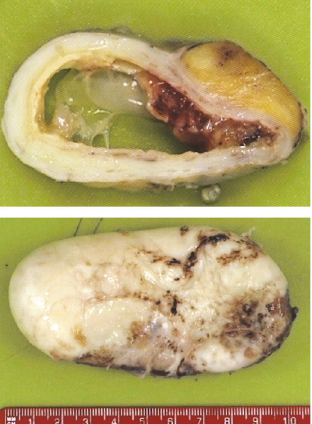
Figure 4: Gross appearance of the mucocele.